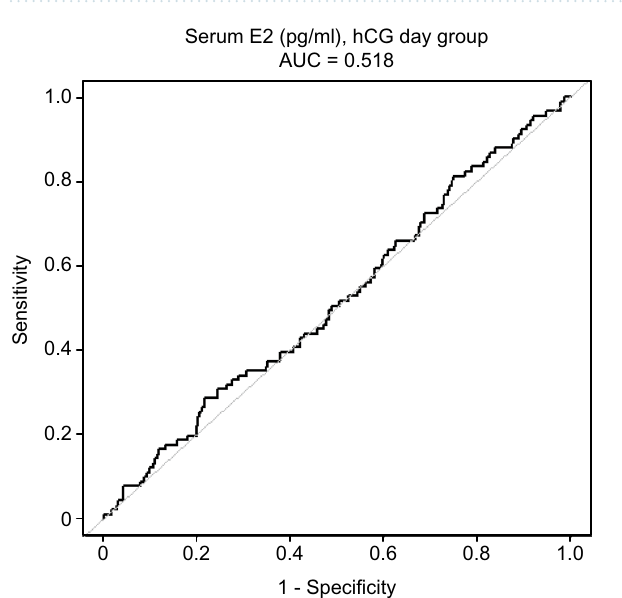
Figure 2. The relationship between serum E2 levels on the trigger day and neonatal birthweight. A nonlinear relationship between serum E2 levels and neonatal birthweight was observed after adjusting for maternal age, maternal BMI, number of embryos transferred, neonatal sex.